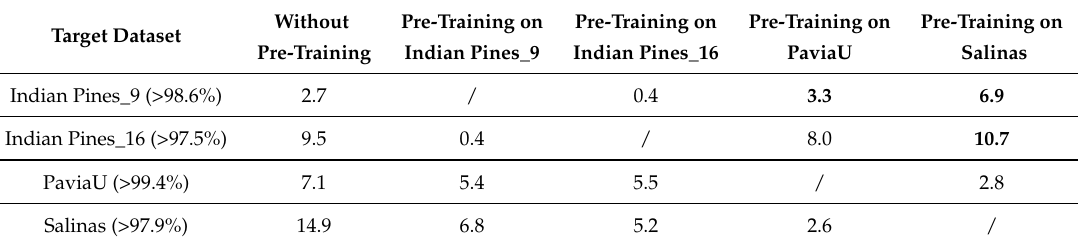
Table 13. Time (hour) for training ASSP-SCNN without pre-training or fine-tuning the pre-trained ASSP-SCNN on three HSI target